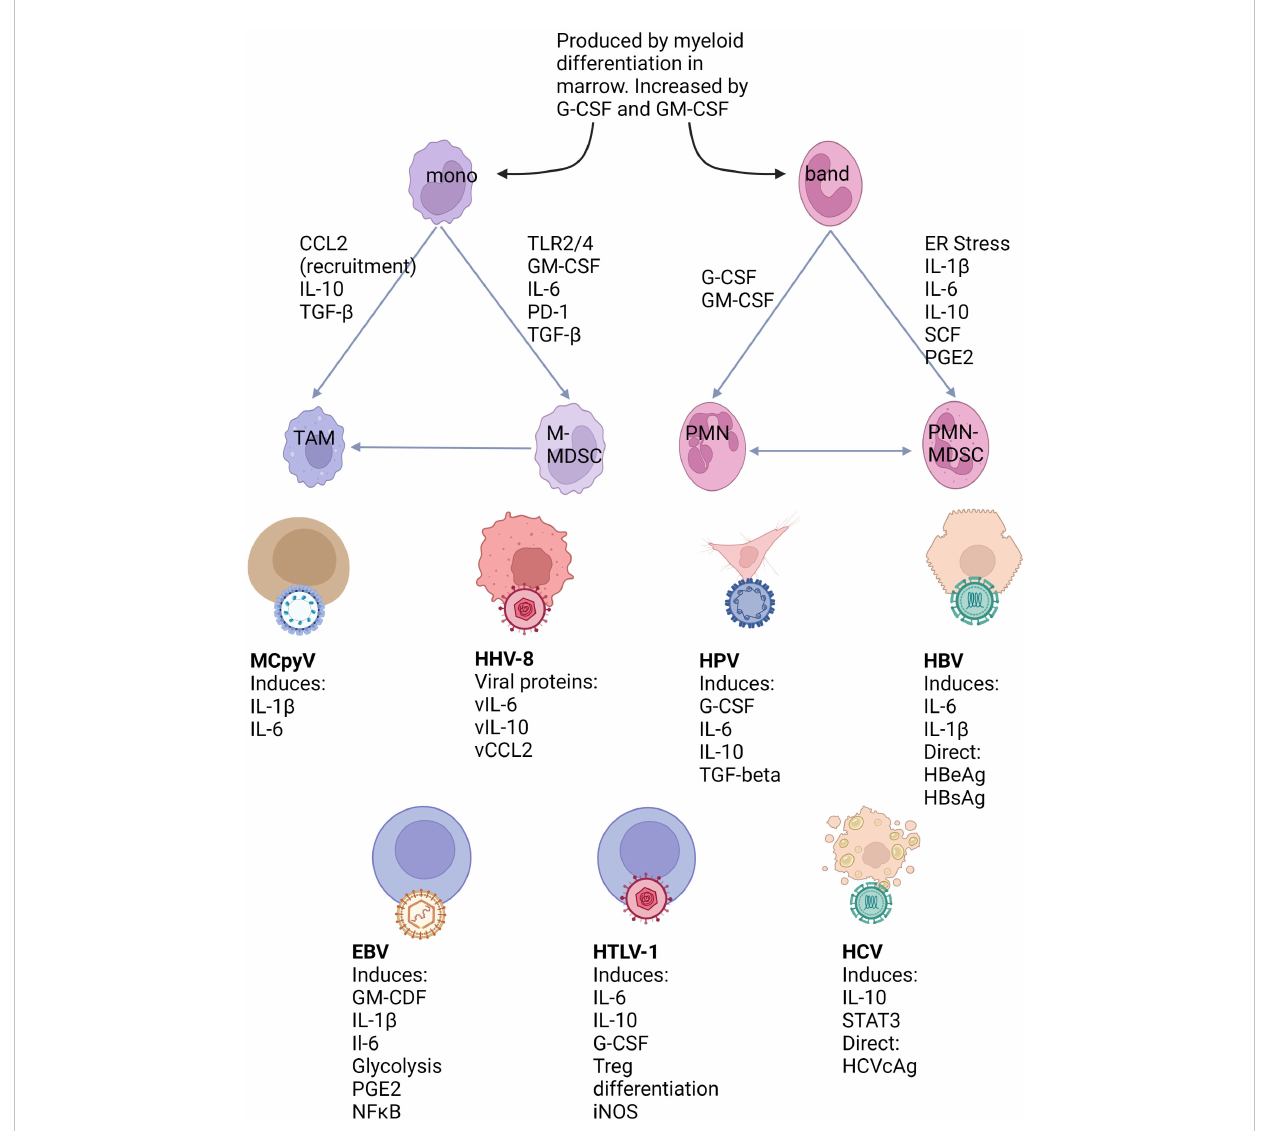
FIGURE 1 Mechanisms of MDSC generation and their relation to virus associated cancers. Myeloid cells are produced during myelopoiesis in the marrow in both steady state and in fl ammatory conditions. However, myeloid differentiation can be greatly expanded under growth factor control and lead to the release of immature cells into the circulation. Under conditions favouring MDSC development both bands and mature neutrophils can be induced to this phenotype. M-MDSCs arise from classical monocytes and can also differentiate to TAMs. The human oncogenic viruses illustrated below can either directly or indirectly produce factors known to be linked to MDSC differentiation